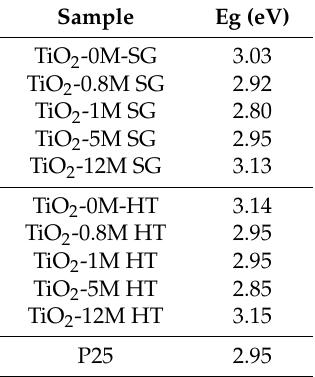
Table 2. Energy band gap for SG and HT photocatalysts and for P25